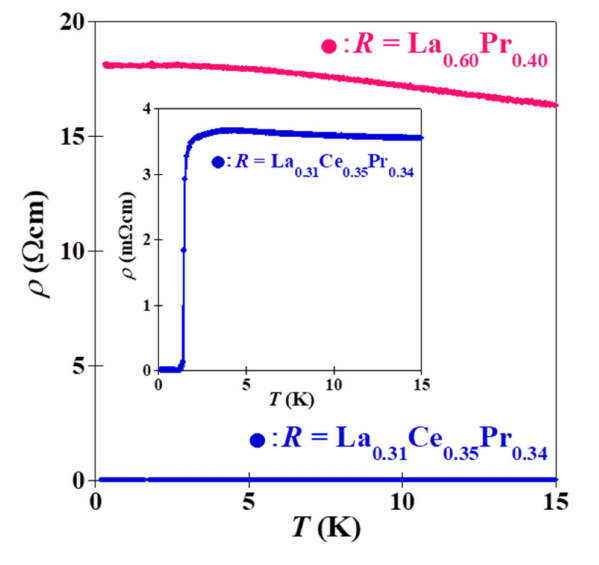
Figure 3. ρ – T characteristics parallel to the c -plane in the temperature range 0.2–15 K for the La 0.31 Ce 0.35 Pr 0.34 OBiS 2 and La 0.60 Pr 0.40 OBiS 2 single crystals. The inset is an enlargement of the lower-resistivity